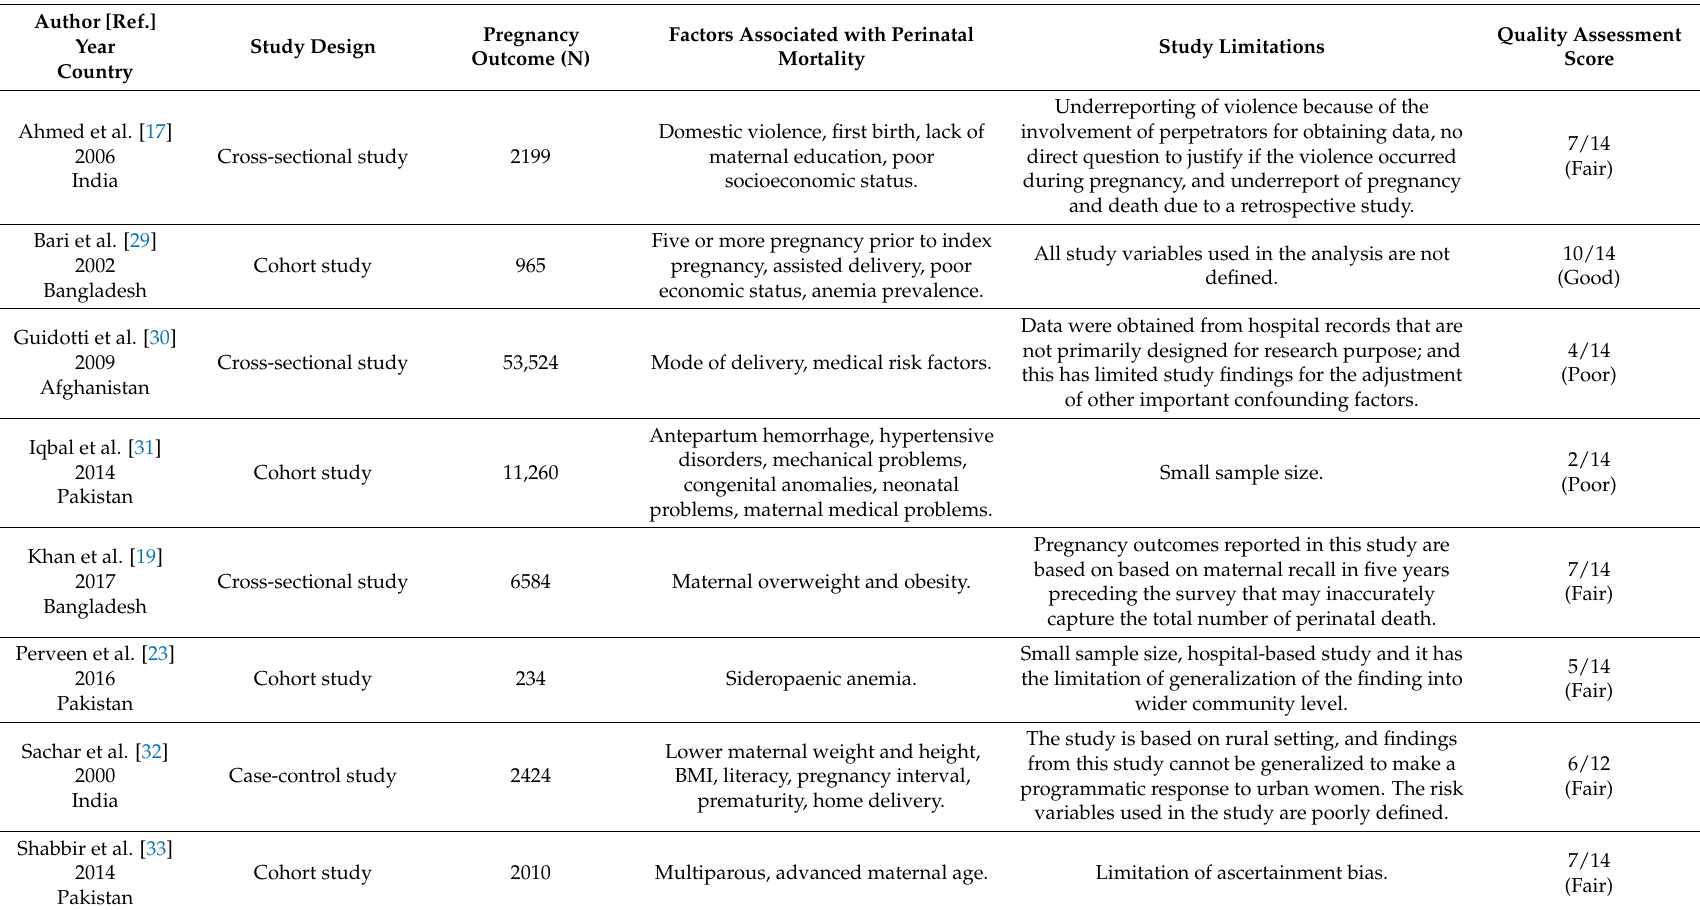
Table 1. Summary of selected